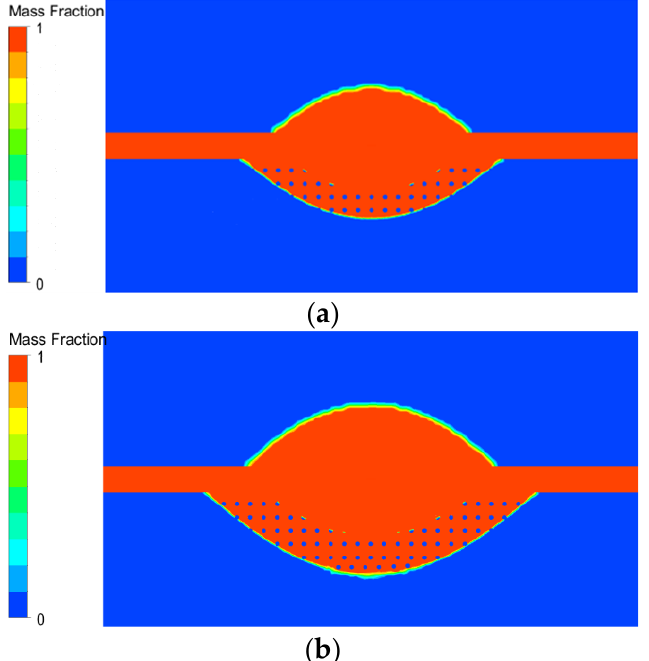
Figure 10. Molten pool on the tool and workpiece at different discharge moments. ( a ) Discharge time at 5 μs; ( b ) Discharge time at 20 μs.